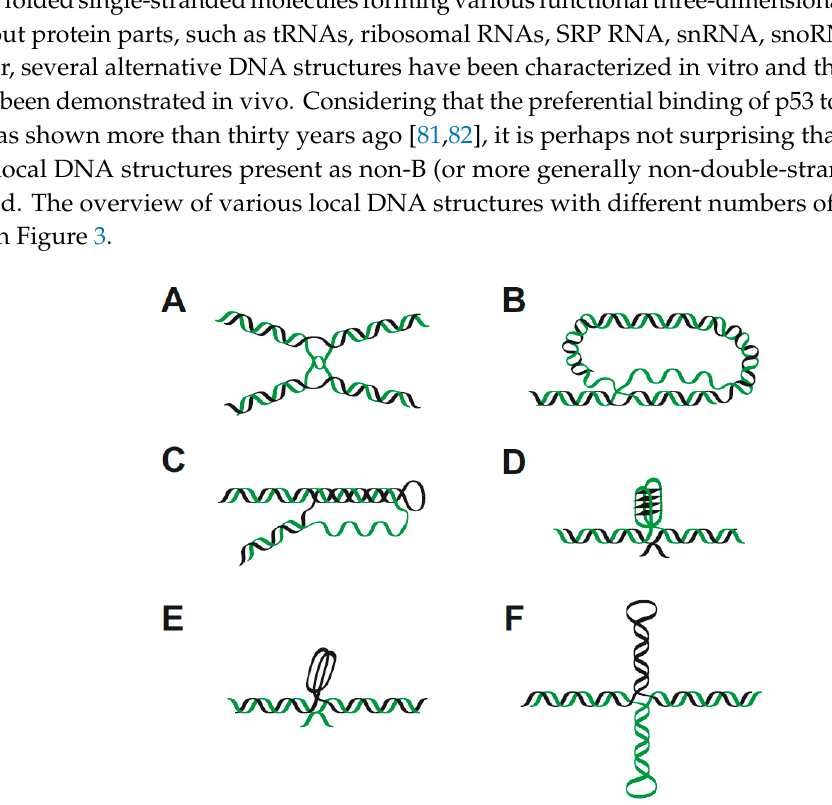
Figure 3. DNA structures with various numbers of strands ( A ) hemicatenate DNA (single- and four-stranded parts), ( B ) T-loop (single-, four-stranded part with DNA junction) ( C ) Triplex DNA (single- and three-stranded DNA), ( D ) G-quadruplex (four-stranded) ( E ) I-motif (four-stranded) ( F ) Cruciform with loops (single-, double- and four-stranded junction). Parts B, C, D, and F are adapted from